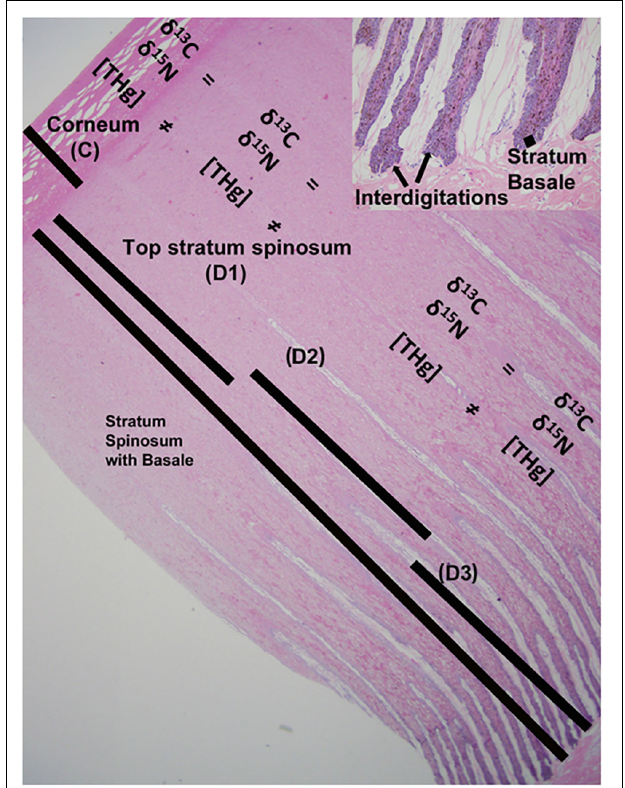
FIGURE 1 | Gray whale epidermis is morphologically and functionally divided into three distinct layers for this study: stratum corneum (C), stratum spinosum, and stratum basale. Depth 1 (D1) includes only stratum spinosum and is equal to the top layer of the spinosum. Depth 2 (D2) is the distal portion of the epidermal-dermal interdigitation area and is composed of primarily stratum spinosum, with little stratum basale. Depth 3 (D3) is the proximal portion of the epidermal-dermal interdigitation area and is composed of primarily stratum basale, with little stratum